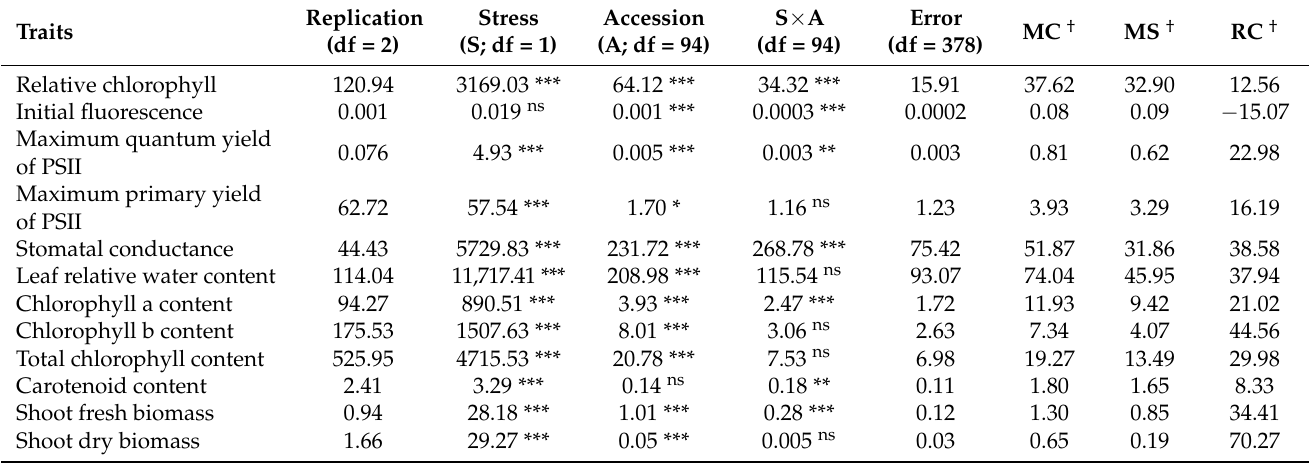
Table 1. Analysis of variance (ANOVA) and mean values for measurements of physiological and biochemical traits across the 95 investigated Ae. taushii and T. aestivum